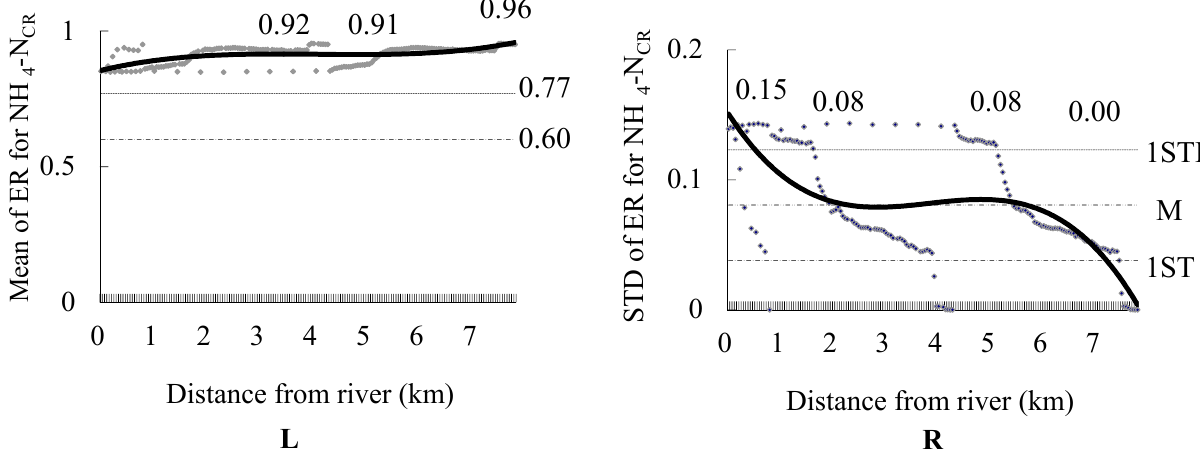
Figure 3. Mean and STD functions of the ERs between TN CR and NH 4 -N CR (dependent index) and the distance of the water channel (independent index) during the gradual buffer extrapolation, based on water channel as a start line in the Sanhuanpao wetland. The curve on the left ( L ) is the mean of the ERs between TN CR and NH 4 -N CR , the curve on the right ( R ) is the STD of the ERs between TN CR and NH 4 -N CR , and the numbers in the figure are the maximum and minimum values of the fitting